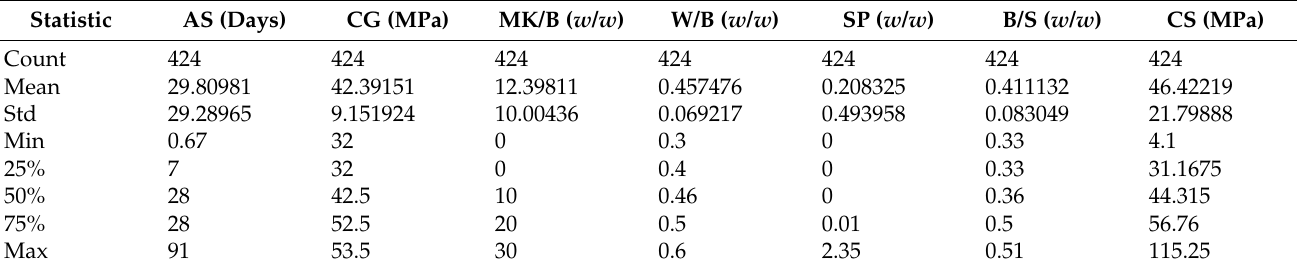
Table 1. Statistical summary of the dataset.